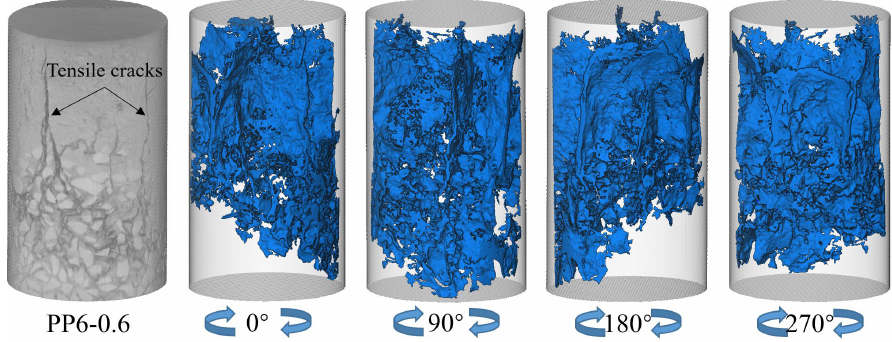
Figure 9. 3D reconstructed image of the cracks in PP6-0.6.